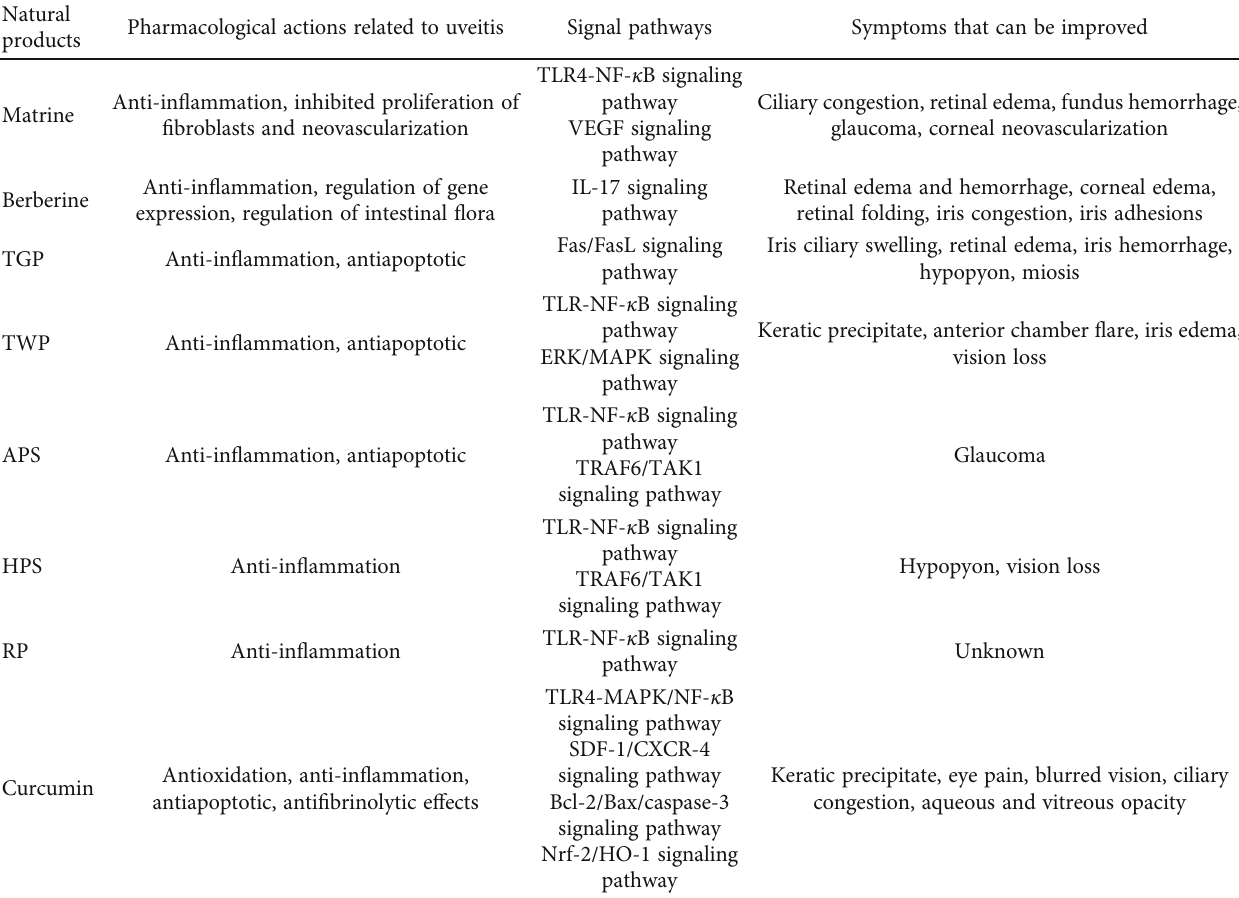
Table 3: Pharmacological actions on uveitis and related signal pathways of natural